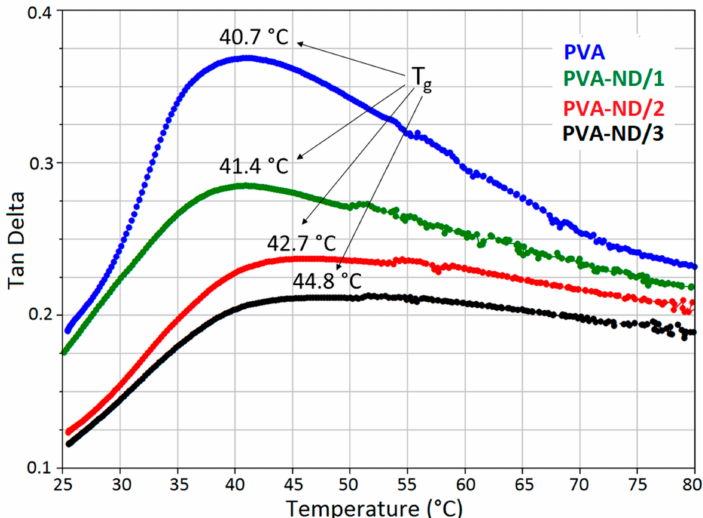
Figure 11. Mechanical properties and T g of the PVA and the PVA-ND